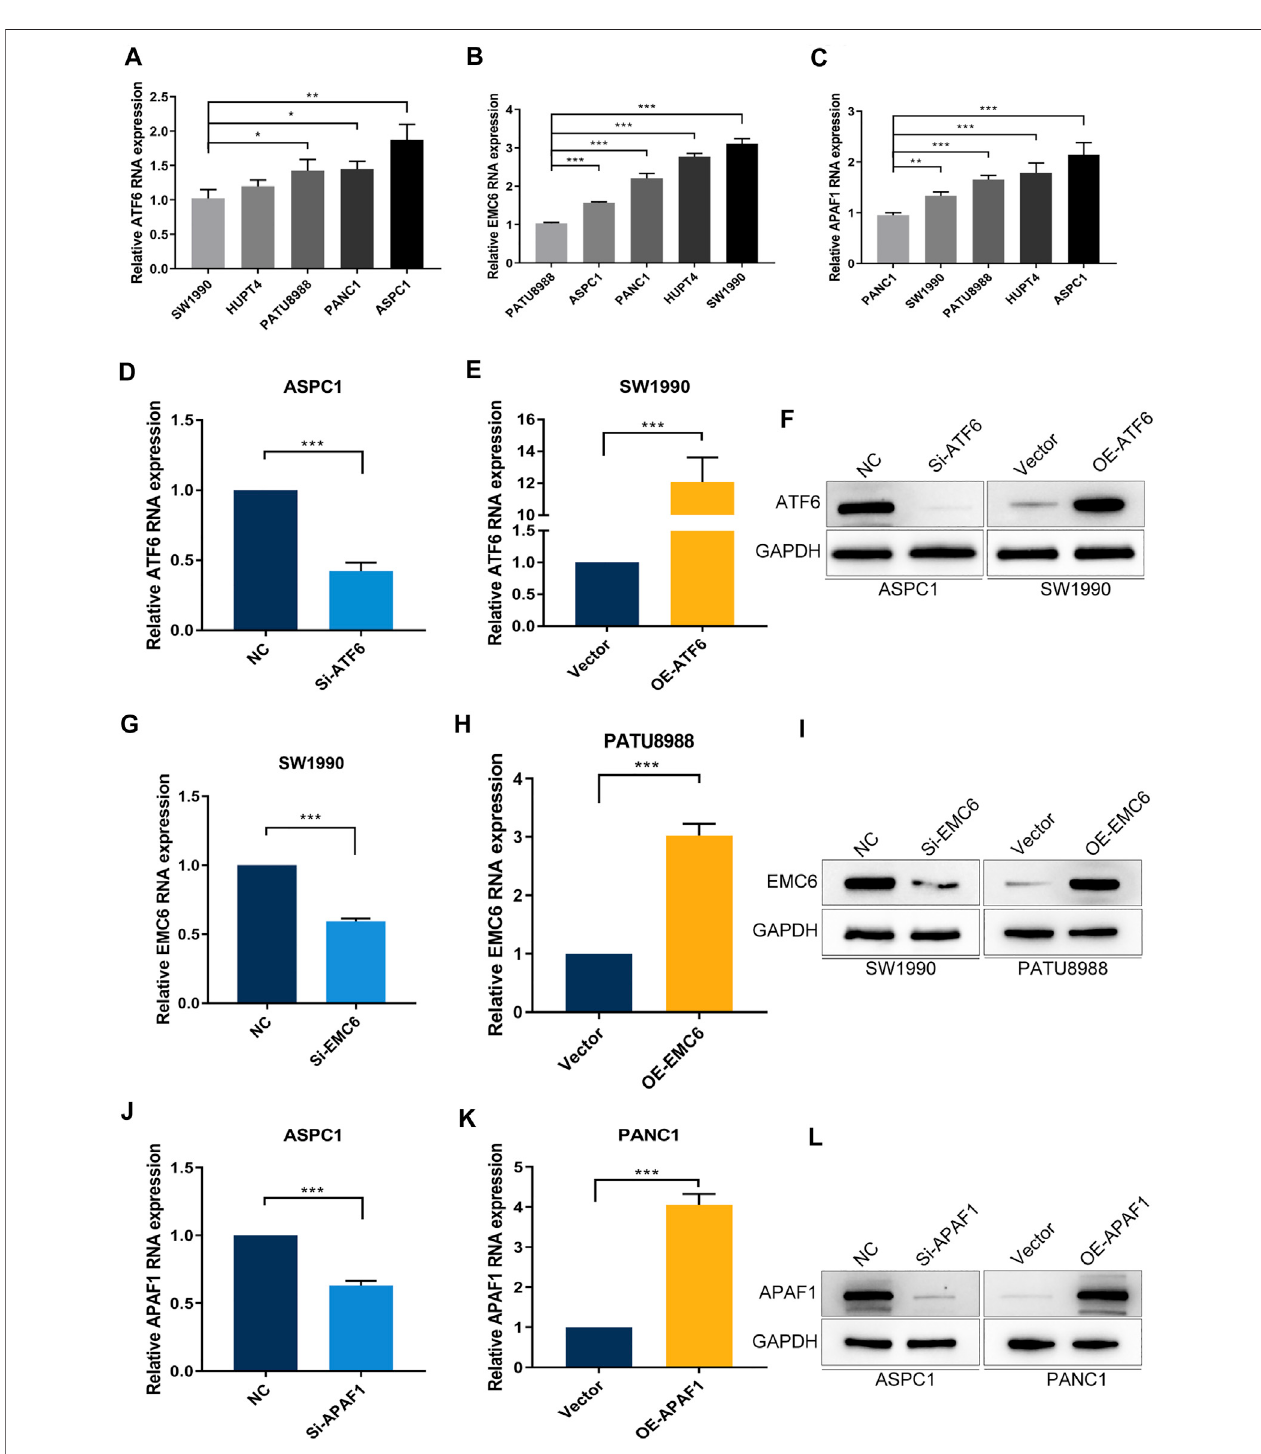
FIGURE4| PCcelllineswithdifferentexpressionlevelsofATF6,EMC6,andAPAF1.Theexpressionof (A) ATF6, (B) EMC6,and (C) APAF1indifferentPCcelllines were detected by qRT-PCR. ATF6 expression in ASPC1 and SW1990 cell lines that were transfected with Si-ATF6 and OE-ATF6, respectively, were detected by qRT- PCR (D,E) and Western blot (F) . The expression of EMC6 in SW1990 and PATU8988 cell lines that were transfected with Si-EMC6 and OE-EMC6, respectively, were measured by qRT-PCR (G,H) and Western blot (I) . APAF1 expression in ASPC1 and PANC1 cell lines that were transfected with Si-APAF1 and OE-APAF1, respectively, were evaluated by qRT-PCR (J,K) and Western blot (L) . * p ≤ 0.05, ** p ≤ 0.01, *** p ≤ 0.001.